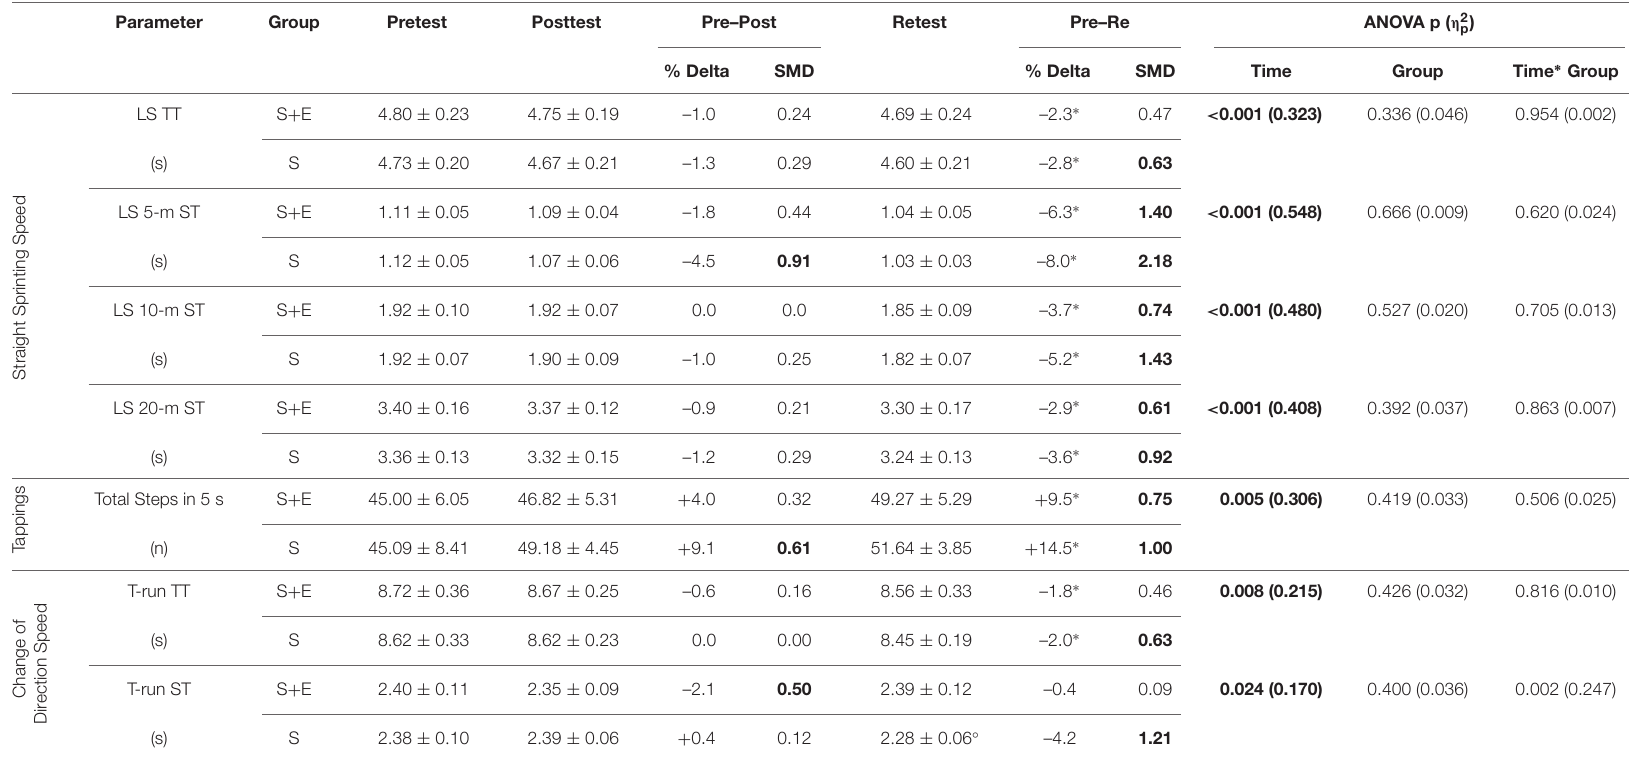
TABLE 4 | Changes in 30-m linear sprint (LS) and in T-run for total time (TT) and split time (ST) as well as in tapping test for total steps in group S (strength training) and S + E (strength training with superimposed WB-EMS) during pre-, post-, and retests. Parameter Group Pretest Posttest Pre–Post Retest Pre–Re ANOVA p ( η 2 p ) % Delta